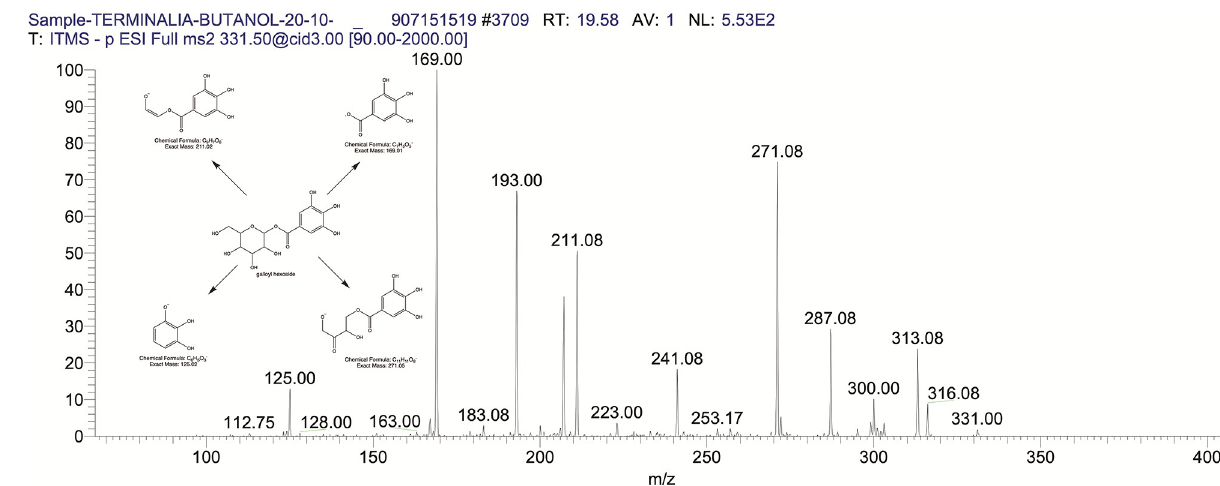
Fig 3. The mass spectrum of galloyl hexoside and its fragmentation pattern.